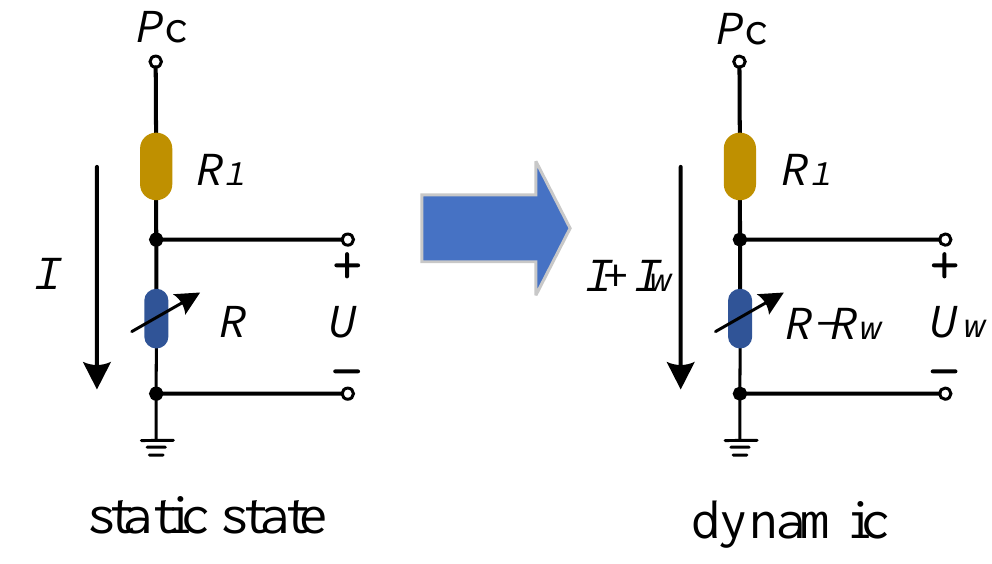
Figure 4. Constant power heating.